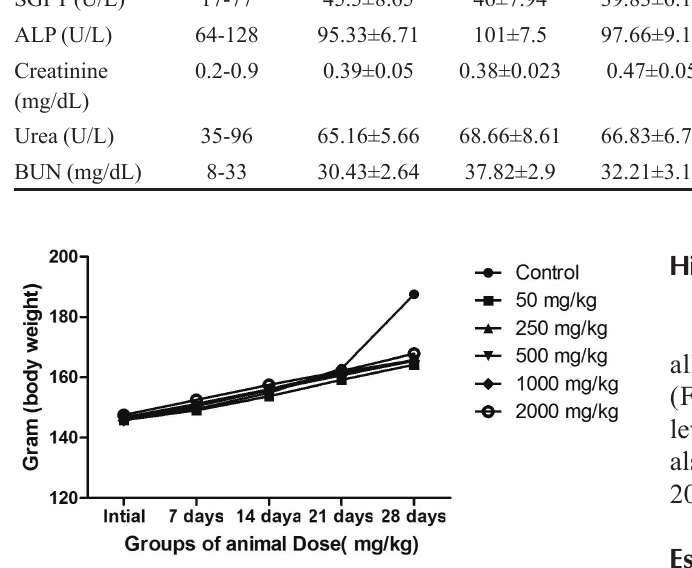
FIGURE 1 - Body weight assessment of treated rats in sub-acute toxicity study.